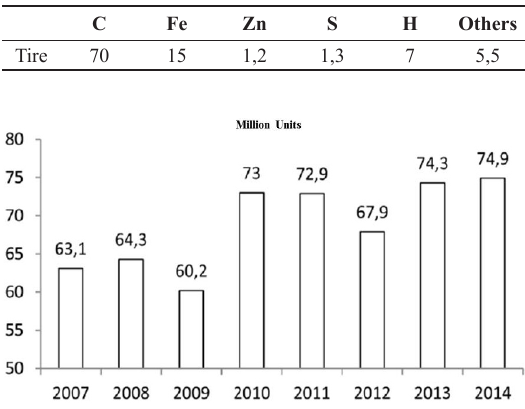
Table 1. Base chemical composition of tire types (%) 7 .